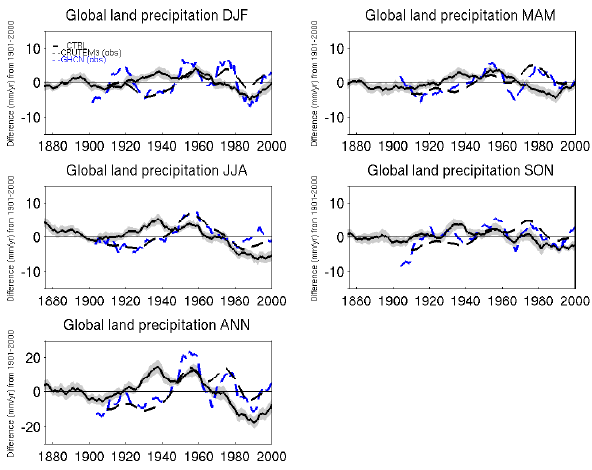
Fig. 6. Simulated annual and seasonal global land temperature anomalies ( ◦ C), relative to the 1870–1880 mean, shown as 11yr running means. Shaded areas correspond to the ± 1 sigma spread of each ensemble.